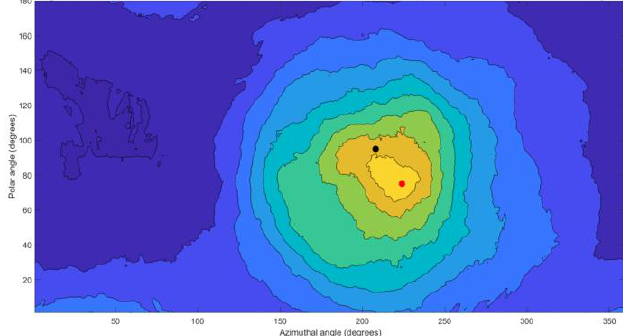
Fig. 14. Improved neutron image of a point source located at (224, 75).